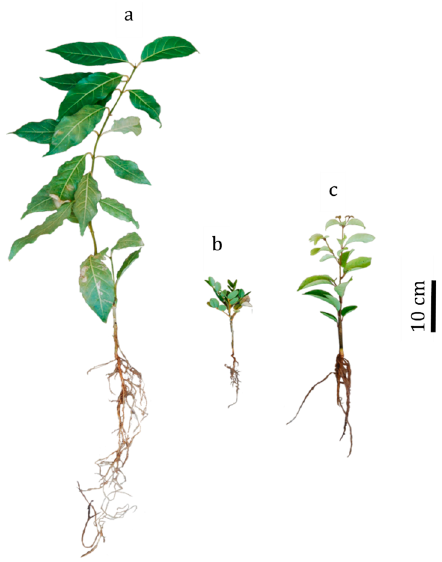
Figure 2. Five-month-old seedlings of C. spinosum ( a ), G. officinale ( b ) and G. fragrans ( c ). C. spinosum was the fastest-growing species and G. officinale the slowest-growing.